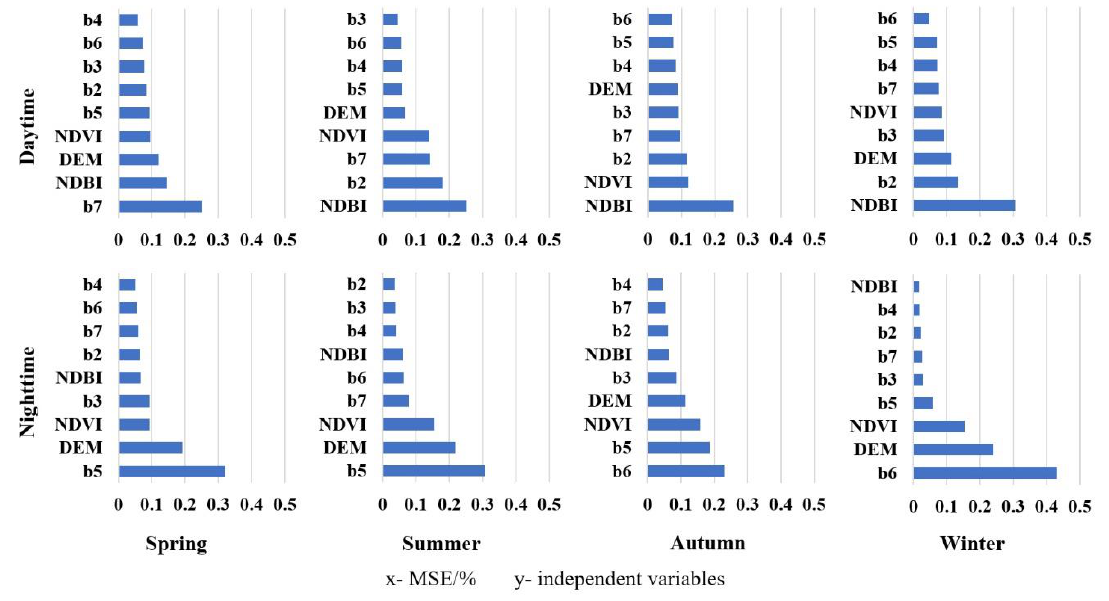
Figure 13. The independent variable importance scores across all research date for RF model. ( x -axis: MSE / %, represents importance scores; y -axis: independent variables).